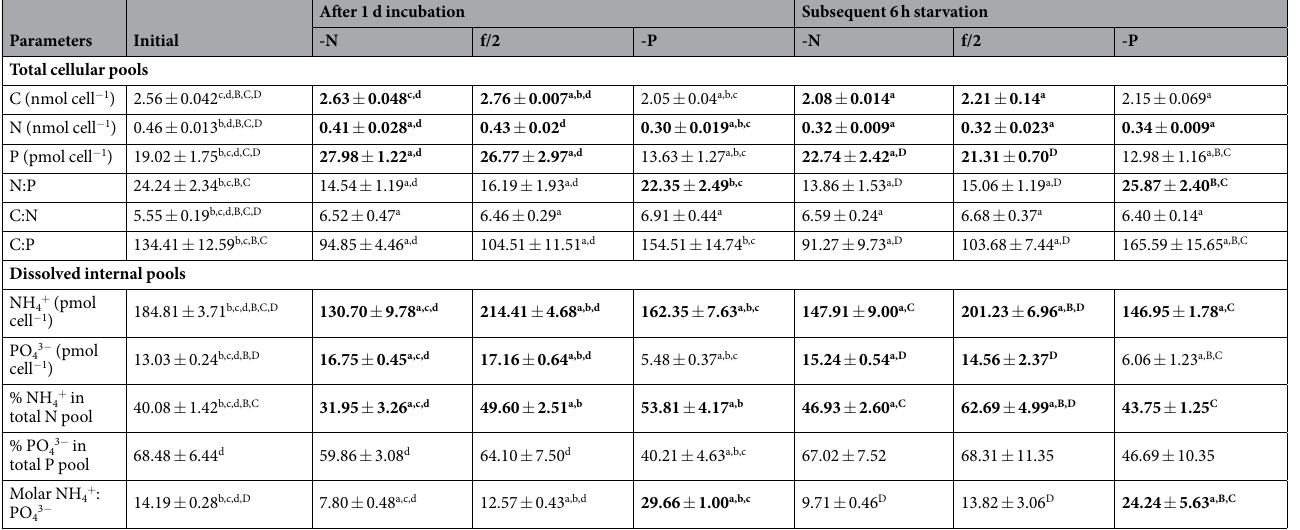
Table 3. The amounts and ratios of total cellular elements and intracellular NH 4 + and PO 43 − of Noctiluca scintillans cells at the initial starved condition, after 1 day incubation with N-limited (-N), nutrient-balanced (f/2) and P-limited (-P) Thalassiosira weissflogii , and after subsequent 6 h starvation of those different grown cells. Superscript letters indicate significant differences between food treatments (ANOVA, Fisher LSD post hoc, p < 0.05), parameters of the Noctiluca from the same food treatment show significant difference after 1 d incubation (before starvation) and after 6 h starvation are labeled in bold .